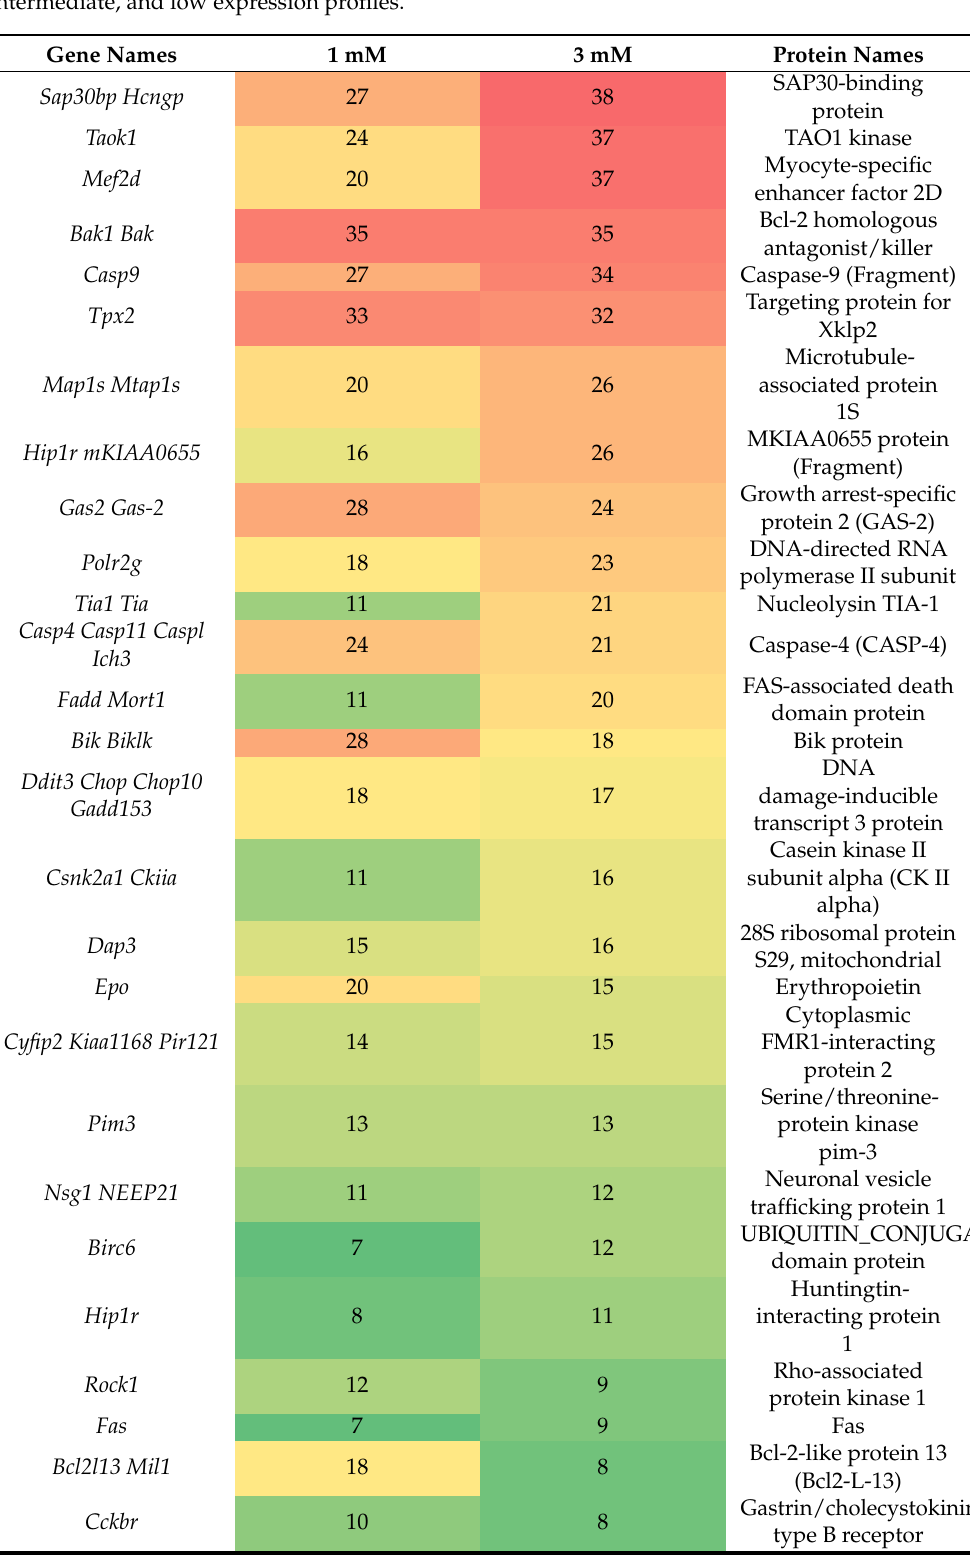
Table 1. A summary of upregulated target genes and corresponding protein profiles in HEI-OC1 exposed to 1 mM and 3 mM concentrations of gentamicin. Red, yellow, and green colors denote high, intermediate, and low expression